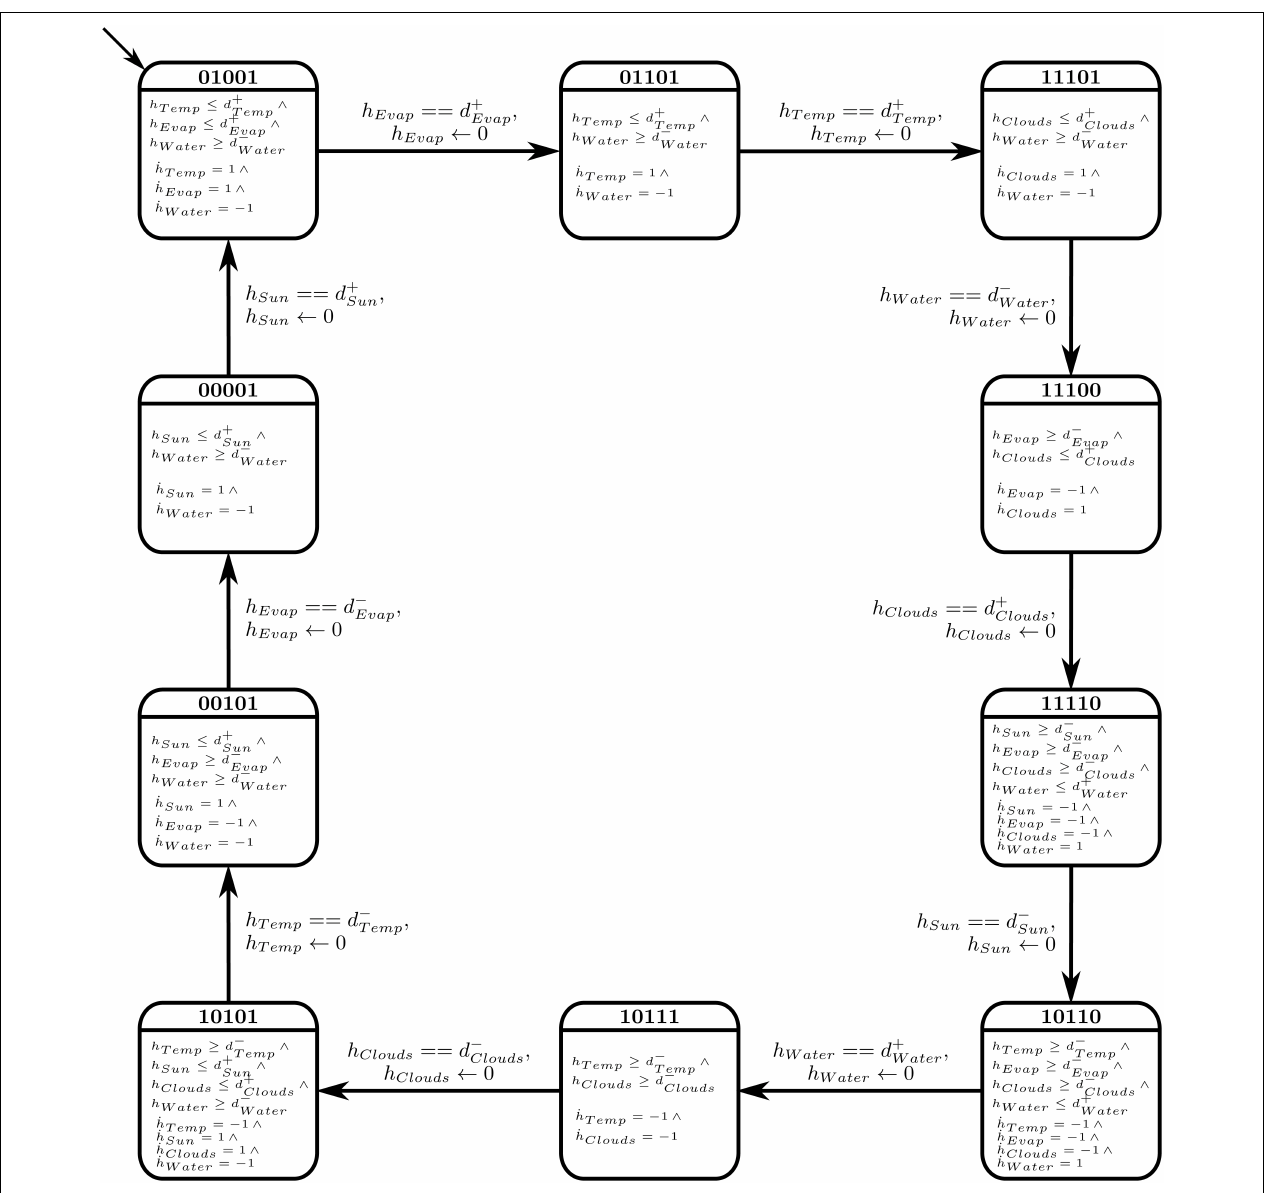
FIGURE 9 | Bio-LHA of Case Study 2: Atmospheric System. To improve readability, only the clock variables with non-zero rates are shown in each